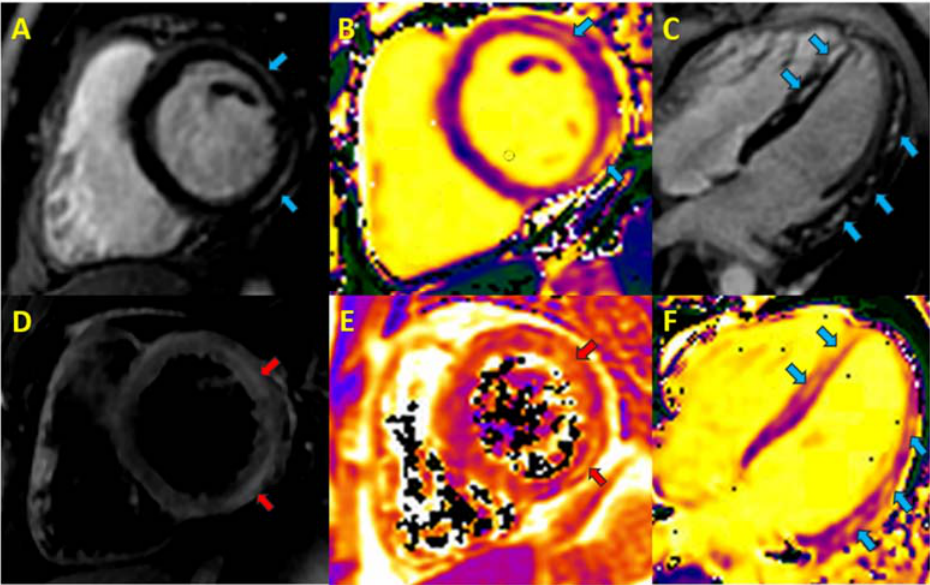
Figure 1. Cardiac magnetic resonance in acute myocarditis. Blue arrows, focal fibrosis; red arrows, myocardial oedema A . Phase ‐ sensitive inversion recovery (PSIR) short axis, lateral subepicardial late gadolinium enhancement (LGE). B . T 1 short ‐ axis map. C . PSIR 4 ‐ chamber long axis, non ‐ ischemic septal and lateral LGE. D . T 2 ‐ short tau inversion recovery short ‐ axis, foci of myocardial edema. E . T 2 ‐ map, myocardial oedema. F . T 1 ‐ long ‐ axis 4 ‐ chamber map.